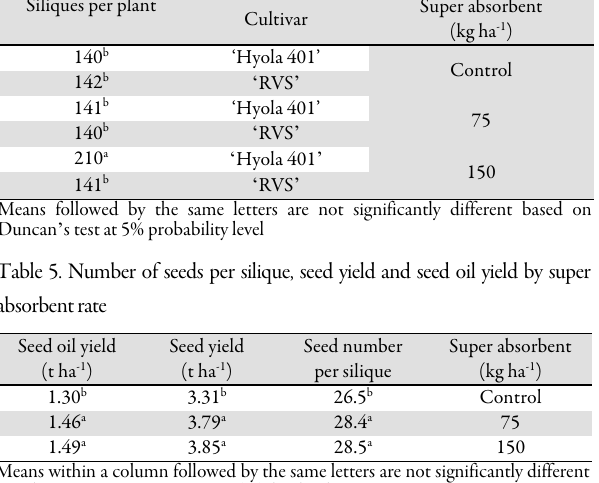
Table 6. Interaction effect between irrigation level (mm) and cultivars on seed